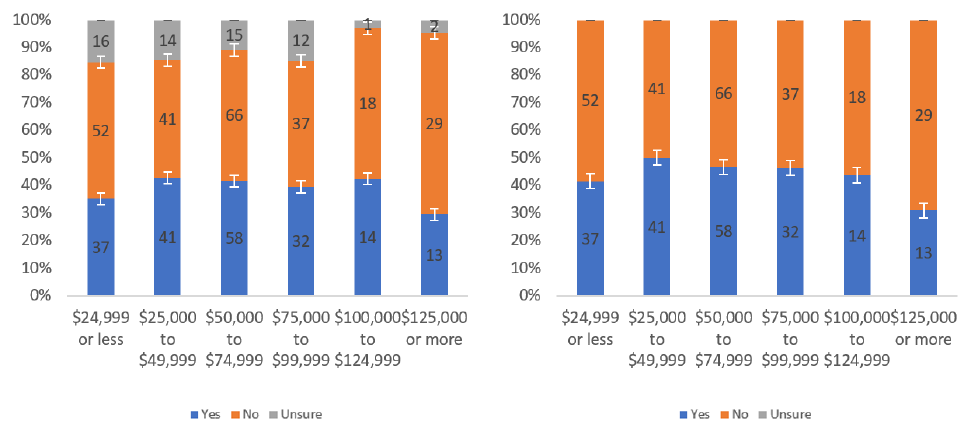
Figure 58. Responses regarding label annoyingness by income level including ( left ) and excluding ( right ) unsure responses.